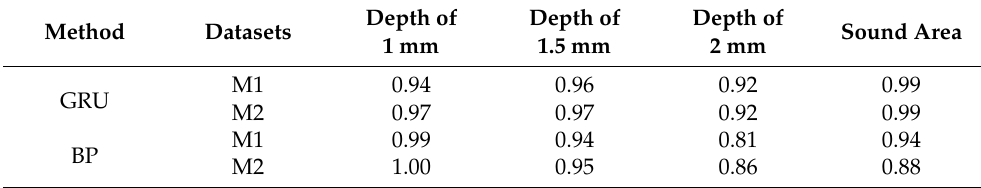
Table 4. The results of defect depth recognition based on datasets M1 and